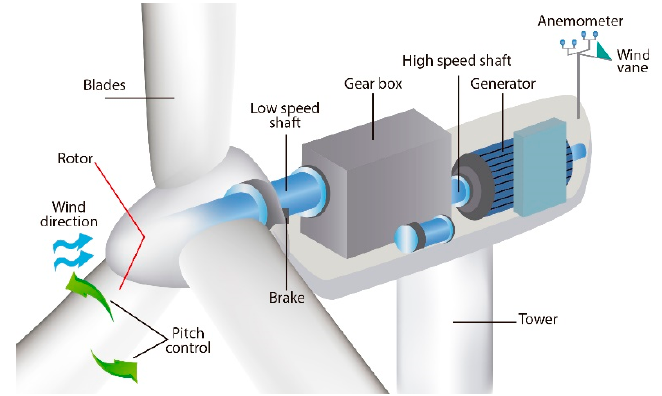
Figure 1. Parts of a wind turbine.